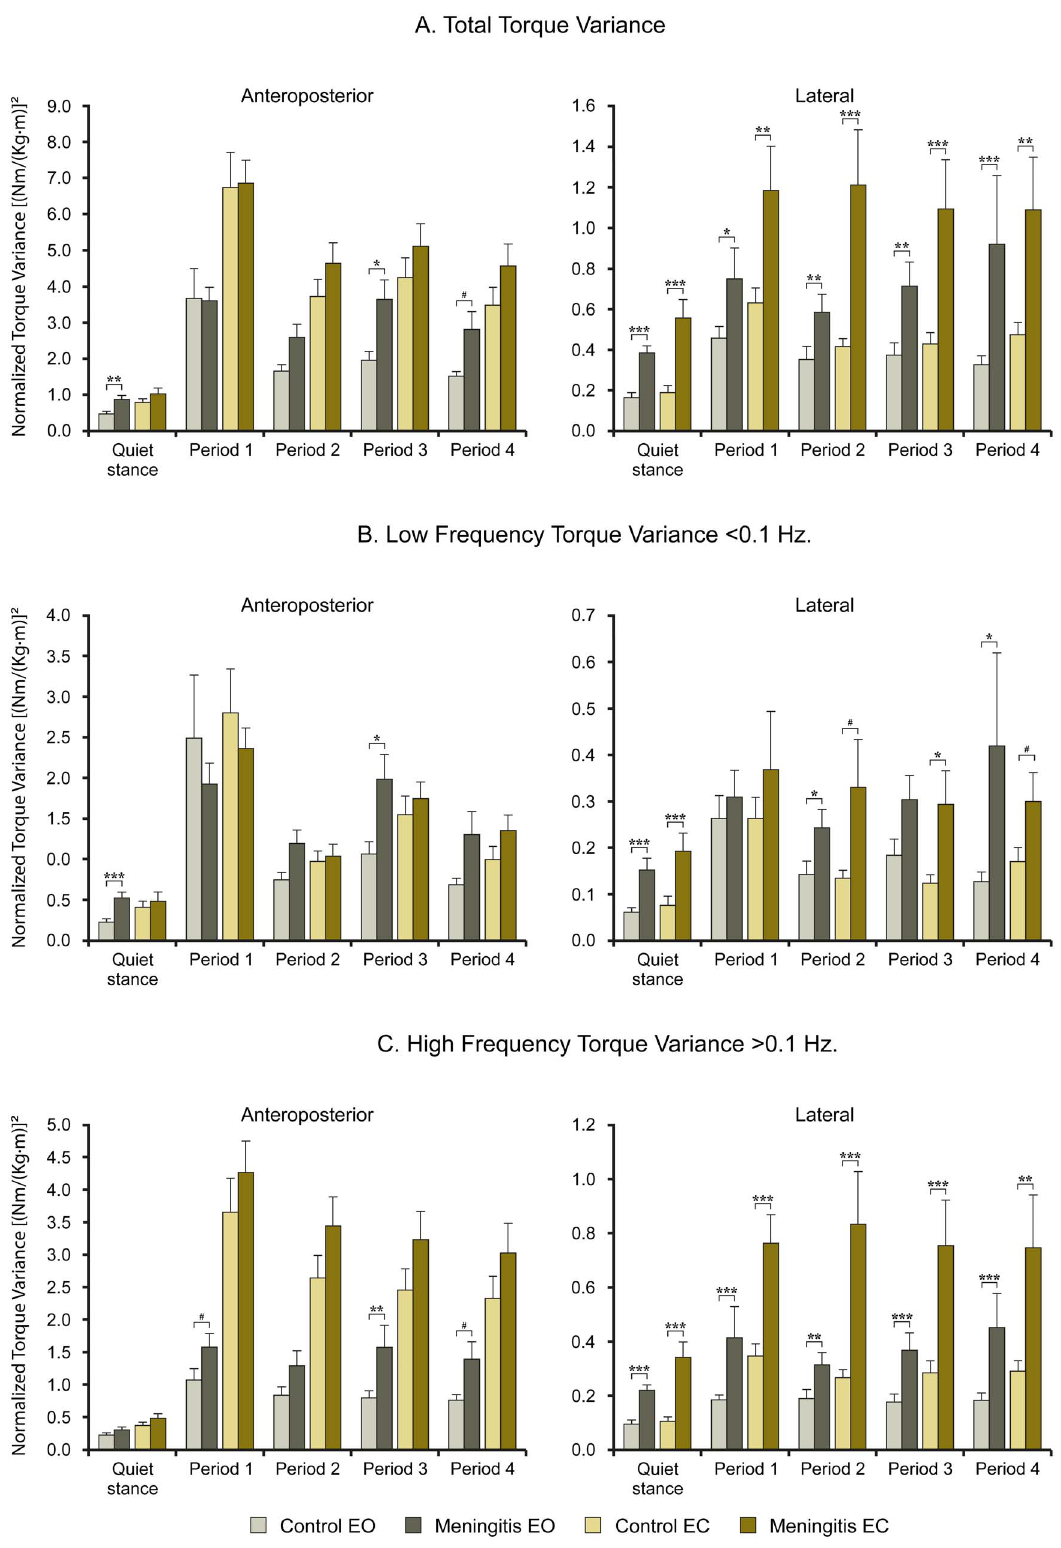
Figure 1. Anthropometrical height and mass normalized values for (A) total, (B) low frequency and (C) high frequency torque variance with Eyes Closed and Eyes Open (mean and SEM) for healthy controls (n=25) and for meningitis treated subjects (n=36). The figures present the statistical findings made in the post hoc evaluation of the main factor meningitis. # denotes p , 0.1 (trends), *denotes p , 0.05, **denotes p , 0.01 and ***denotes p , 0.001.